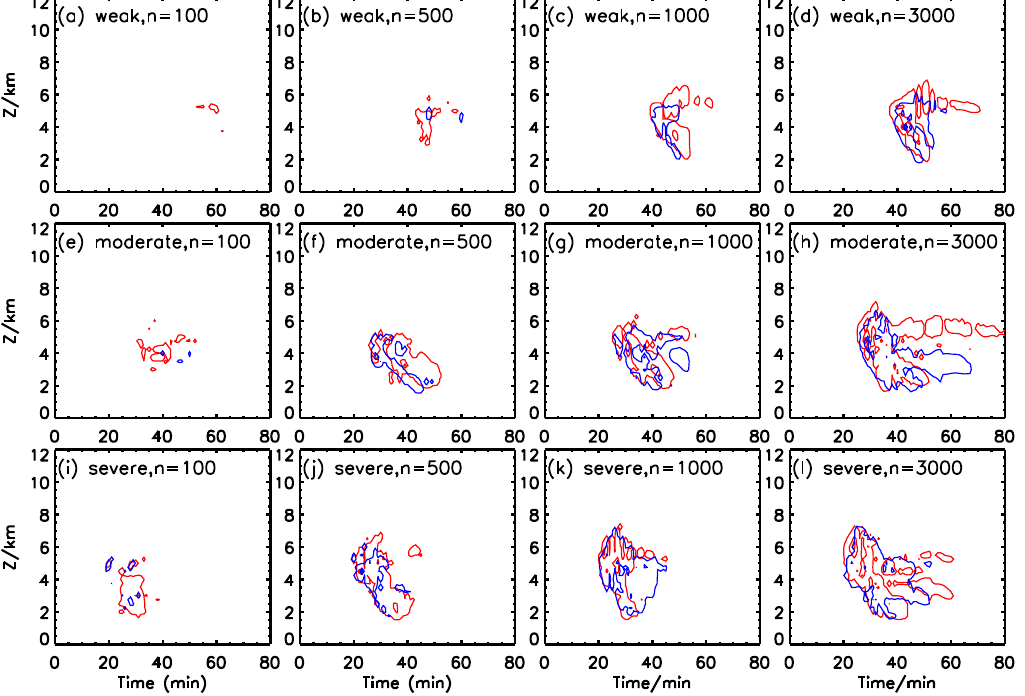
Figure 12. The inductive (by graupel) charging rate evolution ( a – d ) in weak thundercloud (( a ) N 0 = 100 cm − 3 ; ( b ) N 0 = 500 cm − 3 ; ( c ) N 0 = 1000 cm − 3 ; ( d ) N 0 = 3000 cm − 3 ); ( e – h ) in moderate thundercloud; ( i – l ) in severe thundercloud. Positive (red) and negative (blue) charging rates with contour intervals of ± 1, ± 50, ± 100, ± 300, and ± 600 pC m − 3 s − 1 .